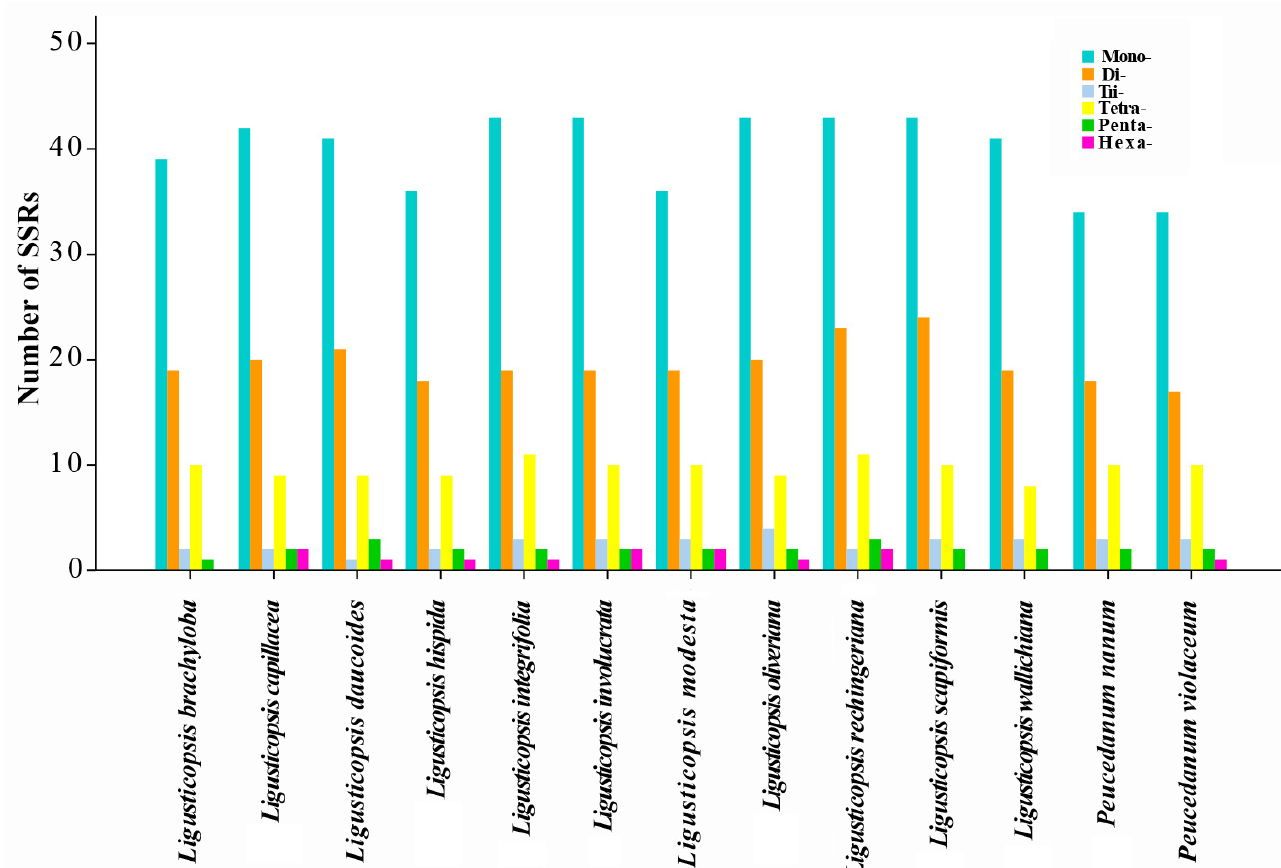
Figure 4. The different repeat types identified in thirteen plastomes.